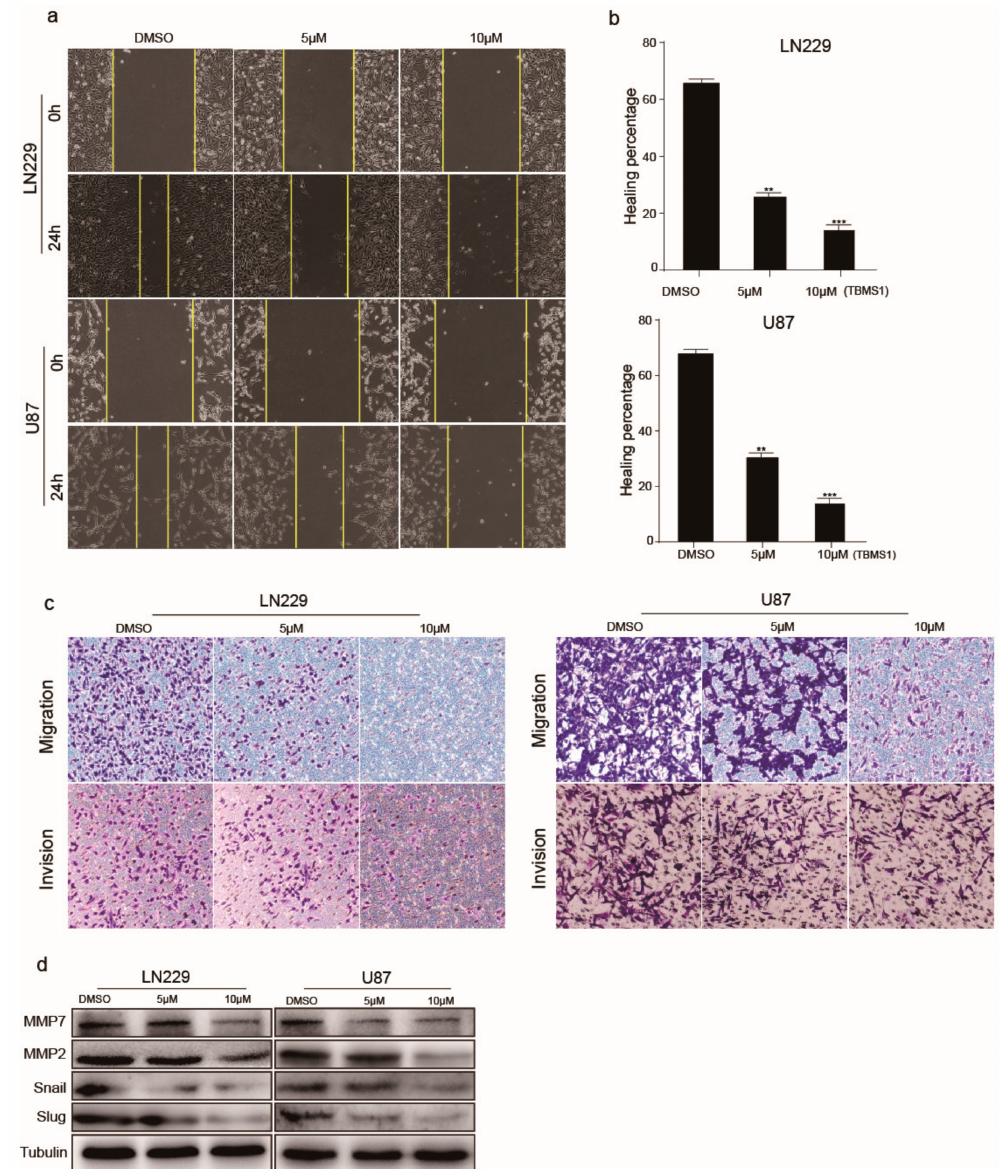
Figure 3. TBMS1 blocks glioblastoma cells migration and invasion. ( a ) The migration ability of glioblastoma cells treated with di ff erent concentrations of TBMS1 was measured by wound-healing assay. DMSO was added as a control. ( b ) According to ( a ) plot, the percentage of cell healing was counted under di ff erent TBMS1 concentrations. ( c ) The invasion ability of glioblastoma cells treated with di ff erent concentrations of TBMS1 was measured by Transwell assay. DMSO was added as a control. ( d ) The expression levels of MMP7, MMP2, Snail, Slug, and Tubulin proteins in LN229 and U87 cells were measured by western blot treated with di ff erent concentrations of TBMS1. DMSO was added as a control. * p < 0.05, ** p < 0.01, *** p < 0.001, p -values < 0.05 were considered as statistically